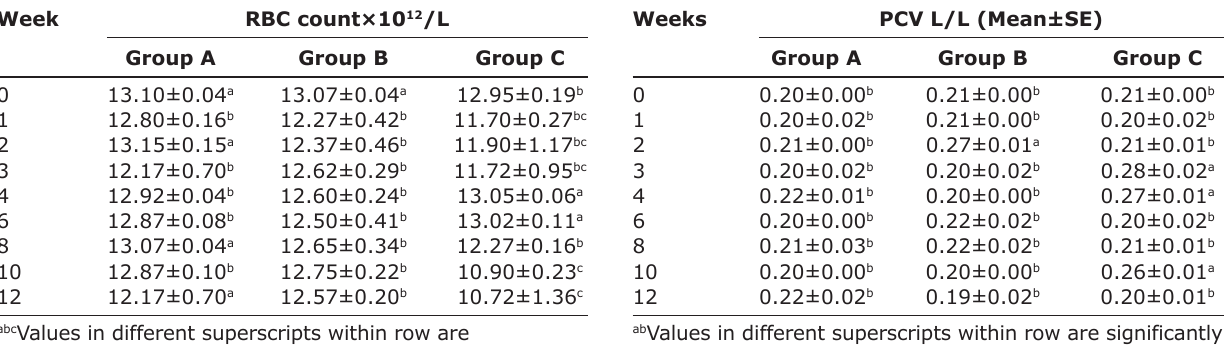
Table-1: RBCs response in female goat’s after inoculation with C. pseudotuberculosis and MA (mean±SE). Week